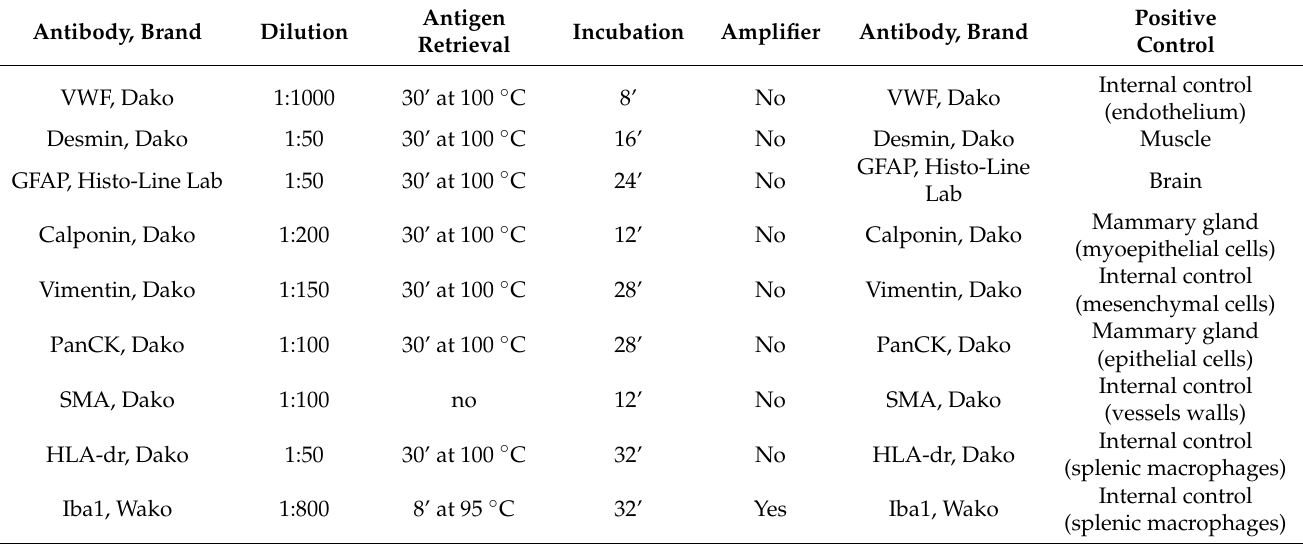
Table 1. List of the tested antibodies and synthesis of the used